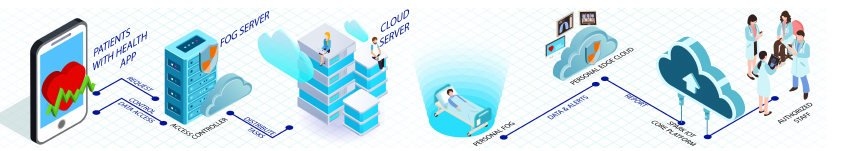
Figure 6. An access control model for the IoMT proposed in [103] and framework of healthcare application